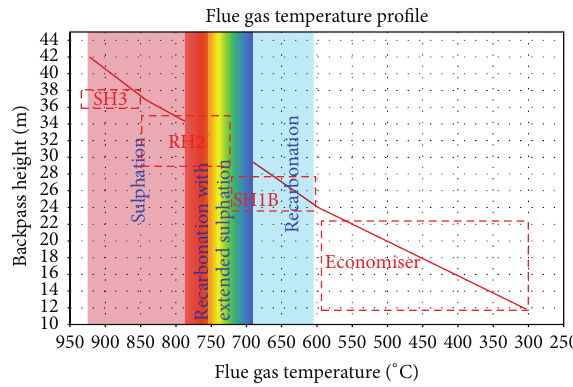
Figure 6: Recarbonation and extended sulfation range and location.